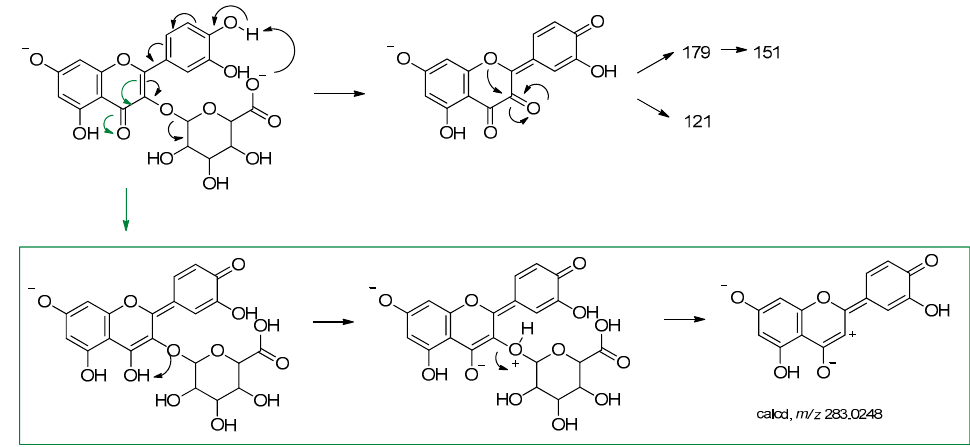
Figure 8. Proposed mechanism for the formation of the ion at m / z 283.0249. The calculated m / z value is reported (error < 5 ppm).